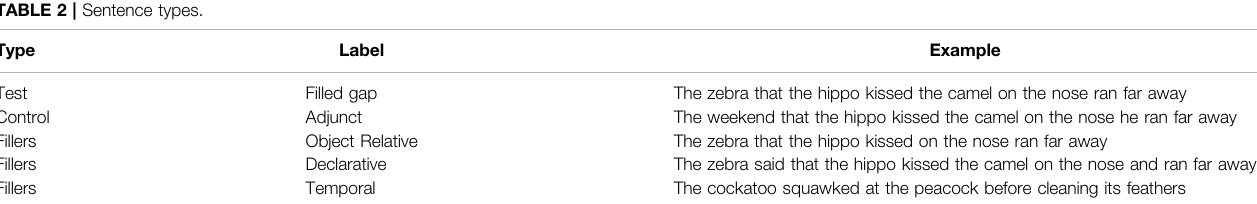
TABLE 2 | Sentence